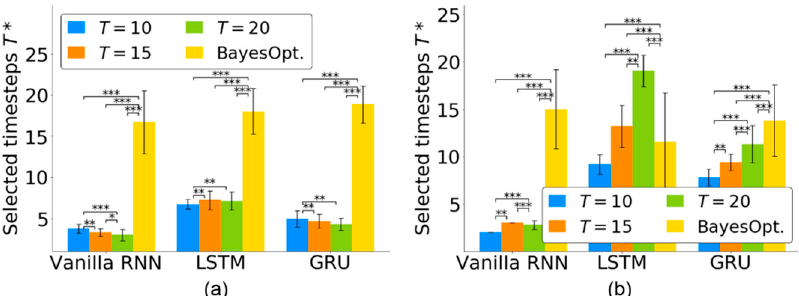
Figure 4. Number of selected timesteps T ∗ in three RNN-based neural decoders for neural activity of length T = 10, 15, 20 from ( a ) monkey Indy and ( b ) monkey N. Each bar represents the mean, and the whiskers represent the standard deviation of T ∗ across 37 sessions over 300 days for monkey Indy and across five independent runs for monkey N. T ∗ was independently obtained in each session. BayesOpt. represents the Bayesian optimization. * p < 0.05, ** p < 0.01, and *** p < 0.001.